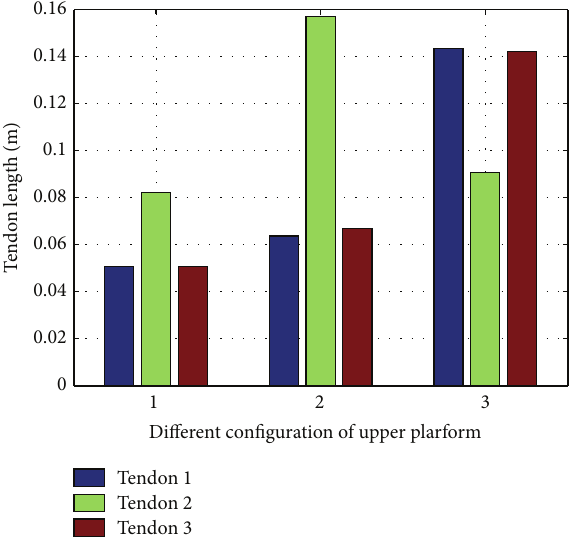
Figure 3: Lengths of the 3 tendons for different configuration. Tendons length versus different configuration of upper platform.